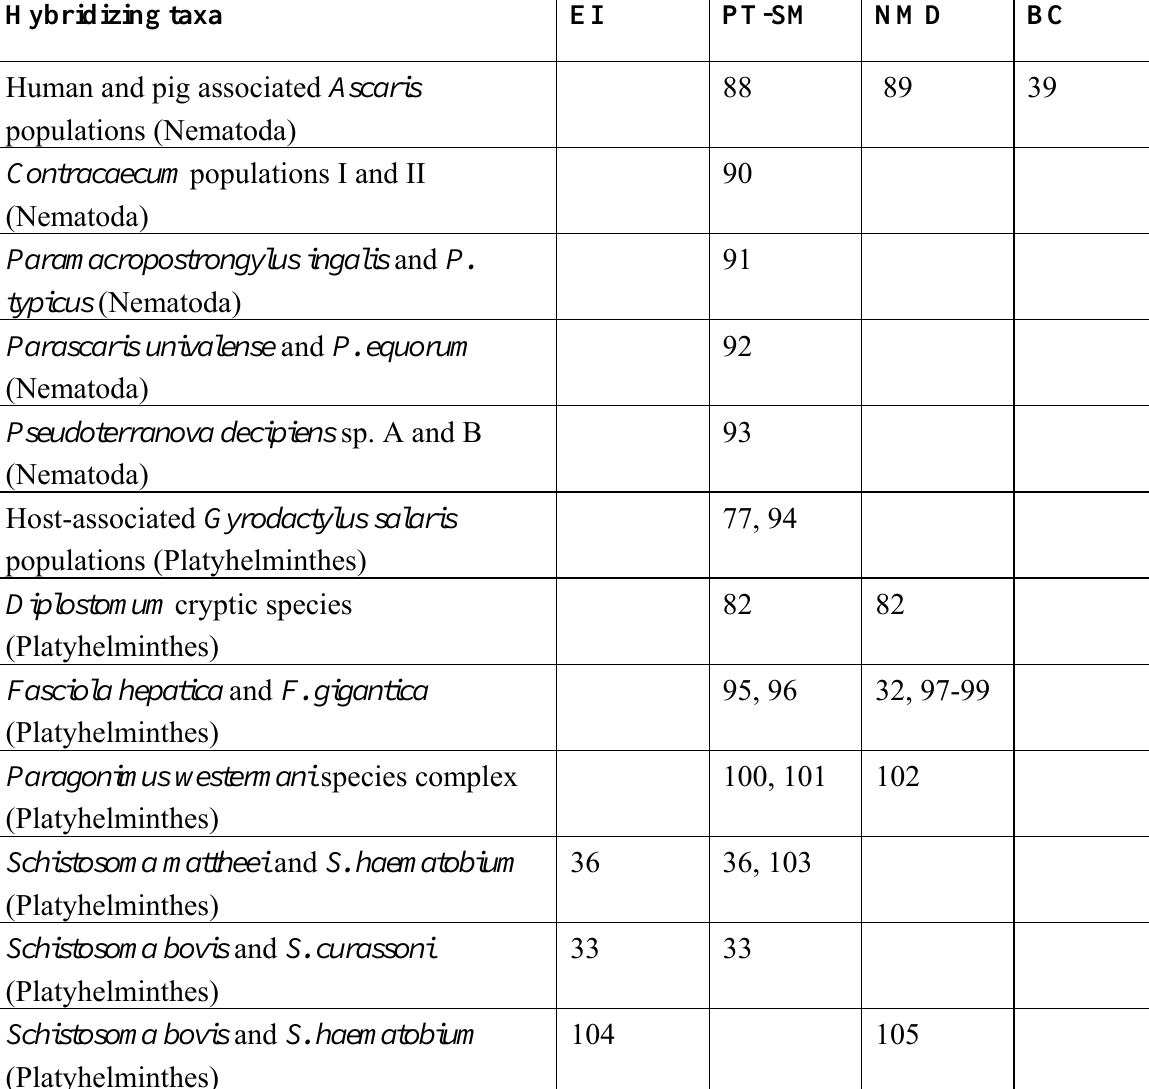
Table 1. Studies providing evidence for natural hybridization in animal parasites. Types of data used to infer hybridization include: experimental infections (EI), parental taxa specific markers (PT-SM), nuclear-mitochondrial discordance (NMD), model-based